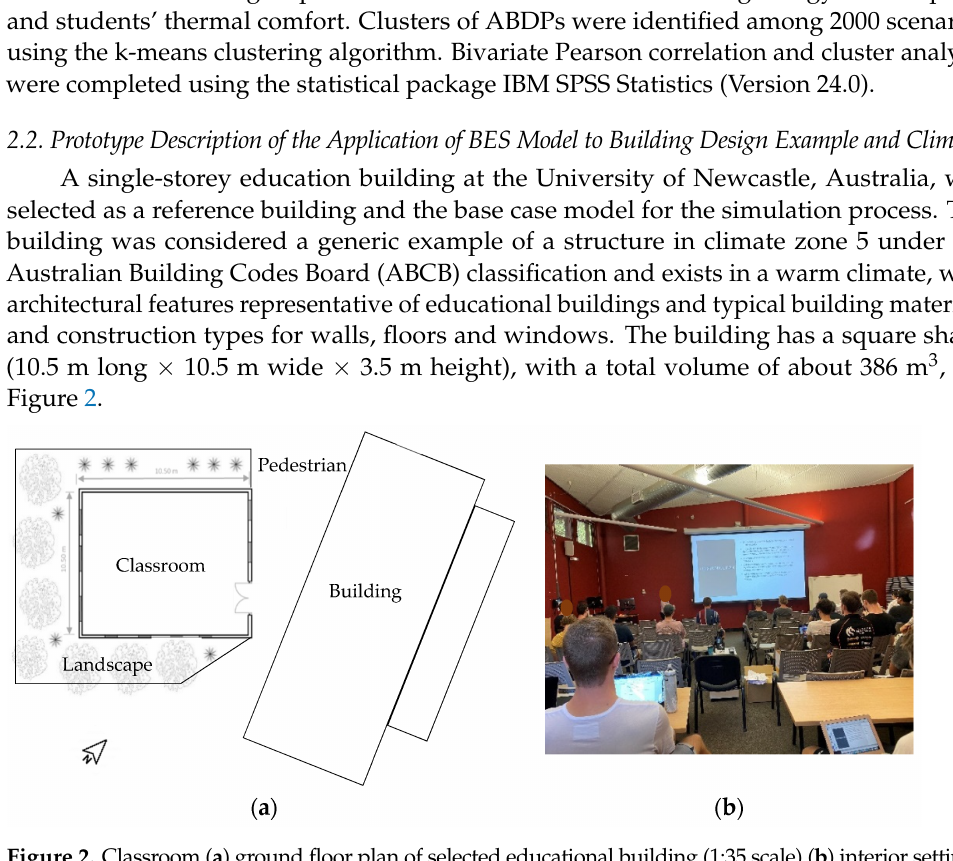
Figure 2. Classroom ( a ) ground floor plan of selected educational building (1:35 scale) ( b ) interior